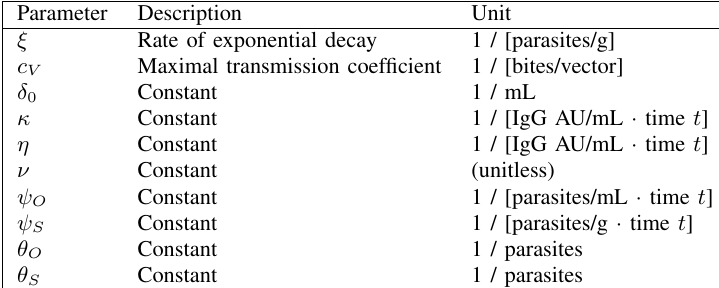
TABLE V: Parameters for